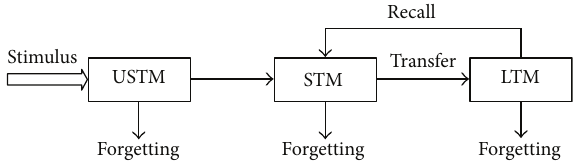
Figure 2: Model of the agent lattice.